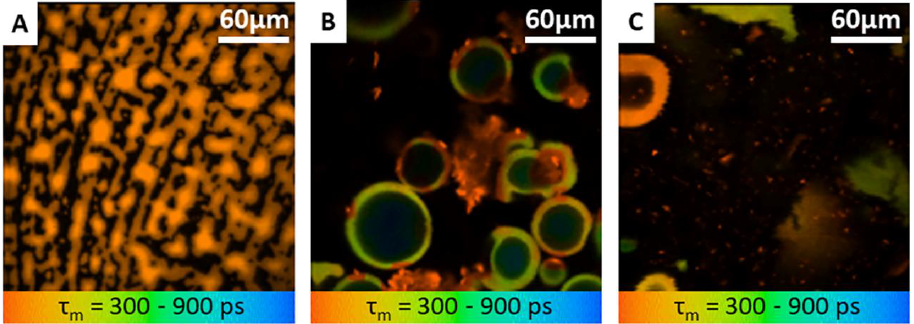
Figure 4. MPT-FLIM images (mean fluorescence lifetime τ m in the 300–900 ps range) of ( A ) conventional RAL solution ( B ) aggregated PRN suspension ( C ) non-aggregated PRN after sonication (760 nm excitation). Orange coloration indicates the retinal, while yellow-green coloration indicates the nanocarriers; chitosan polymeric nanocarriers. All images acquired at 5 mW at 760 nm. The image size is 124 µm.